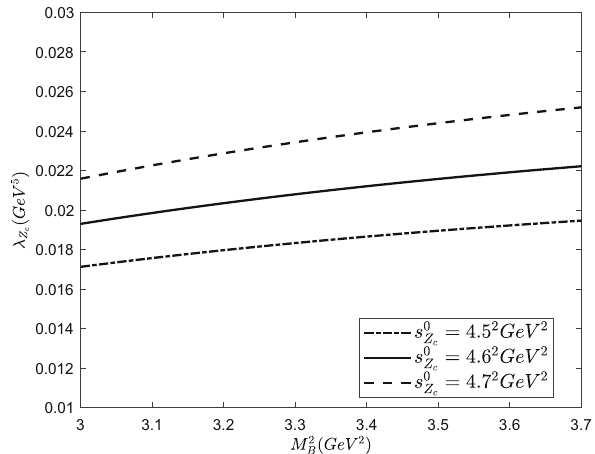
Fig. 3 The figure shows the dependence of the pole residue λ Z Borel parameter M 2 in the determined interval at three different values B of s 0 Z